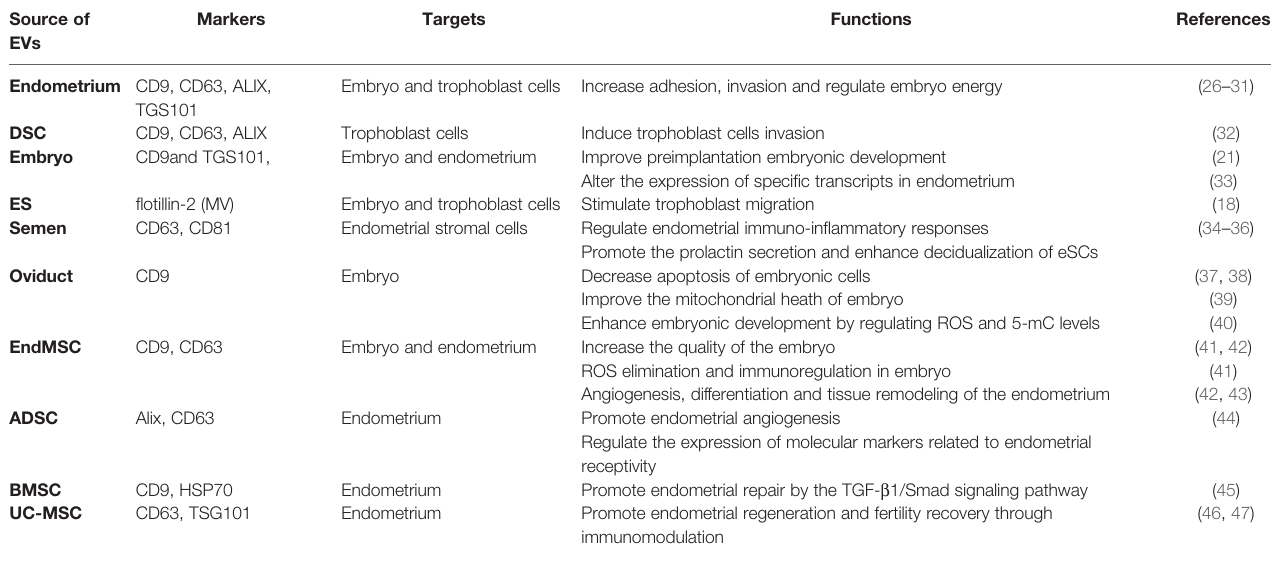
TABLE 1 | Summary of key characteristics of EVs and their implication in embryo